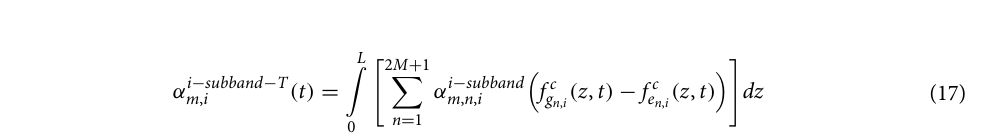
Table 2. The Parameters used in solving rate and propagation Equation 30,33,47–50